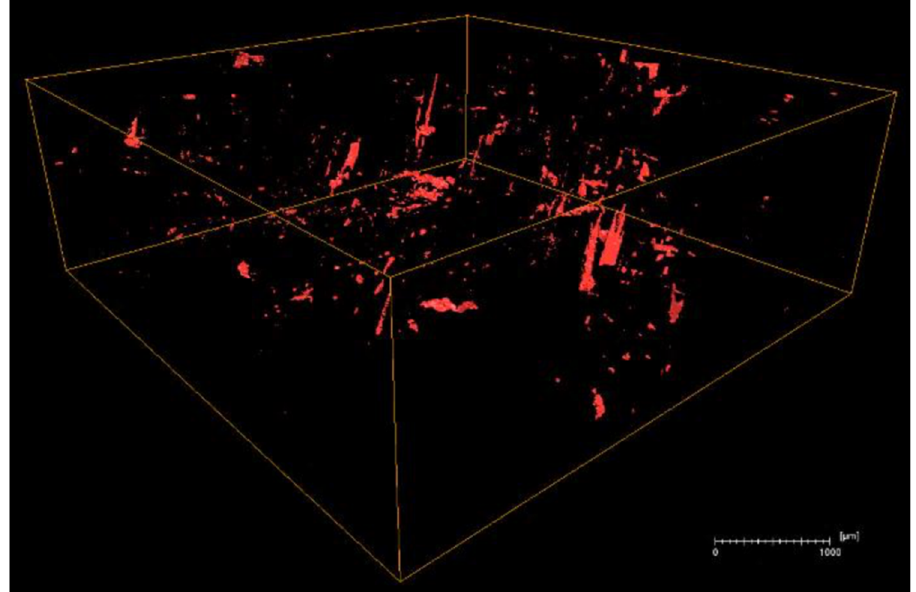
Figure 23. The HRXCT images show the void distribution as relatively uniform, and they take up 0.03% volume of the host, on average.